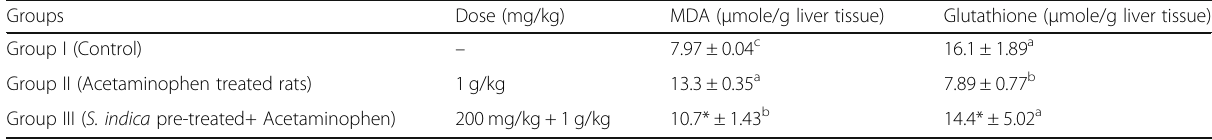
Table 3 Effect of Stokeyia indica on hepatic malondialdehyde (MDA) and glutathione concentration in acetaminophen intoxicated rats